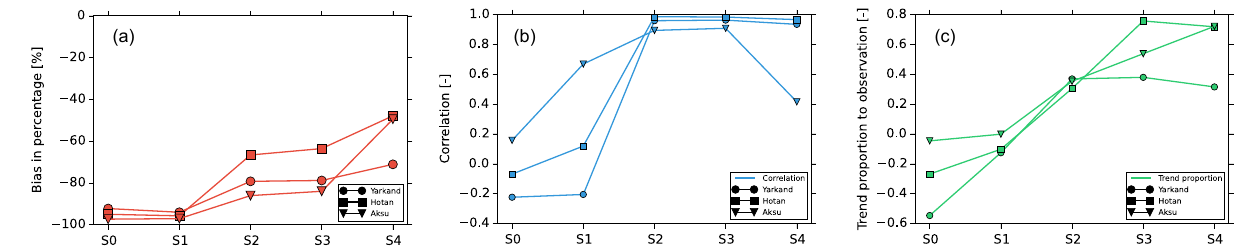
Figure 7. The discharge diagnostics of different experiments for three catchments (round – Yarkand; square – Hotan; and triangle – Aksu). (a) represents the absolute bias in percentage, (b) represents the correlation of the interannual cycle and (c) represents the ratio of the trend in estimated discharge to that in observed discharge for the period 1990–2001. S0 to S4 correspond to the experiments WFD-CRU,